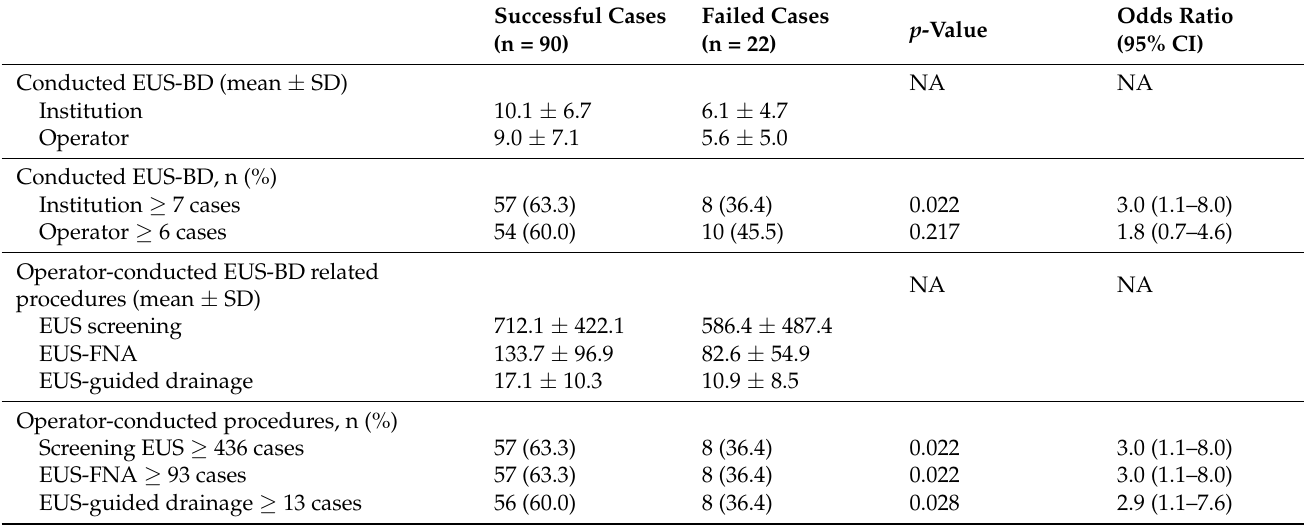
Table 2. Number of EUS procedures conducted and institution and operator experience-related